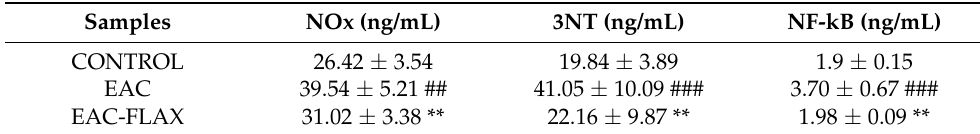
Table 6. Serum anti-inflammatory markers at the end of the experiment.